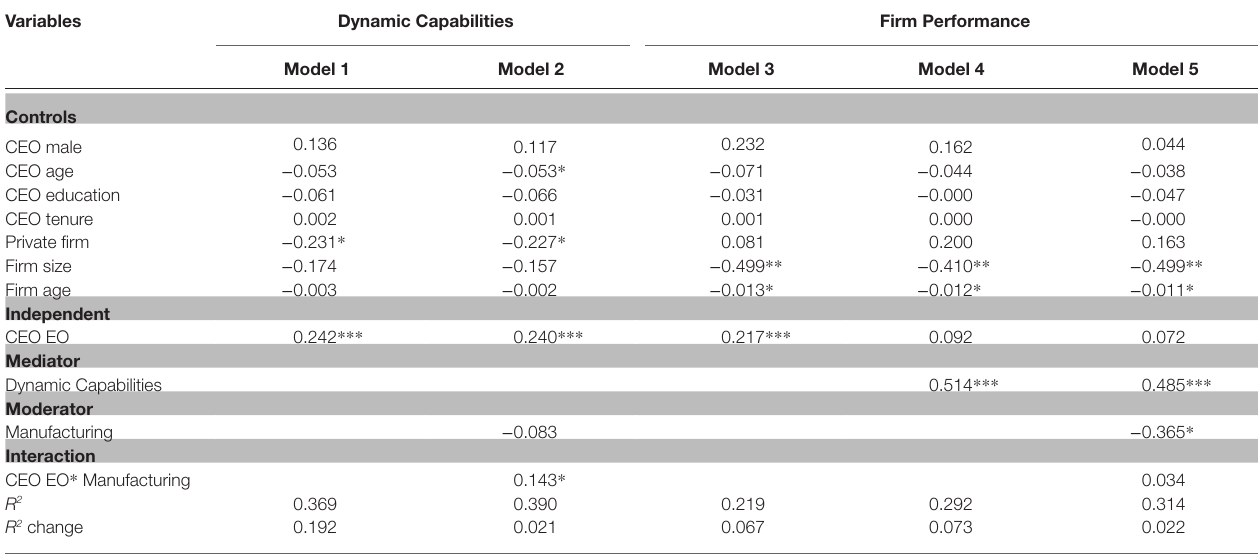
TABLE 2 | Results of regression analysis for dynamic capabilities and firm performance.